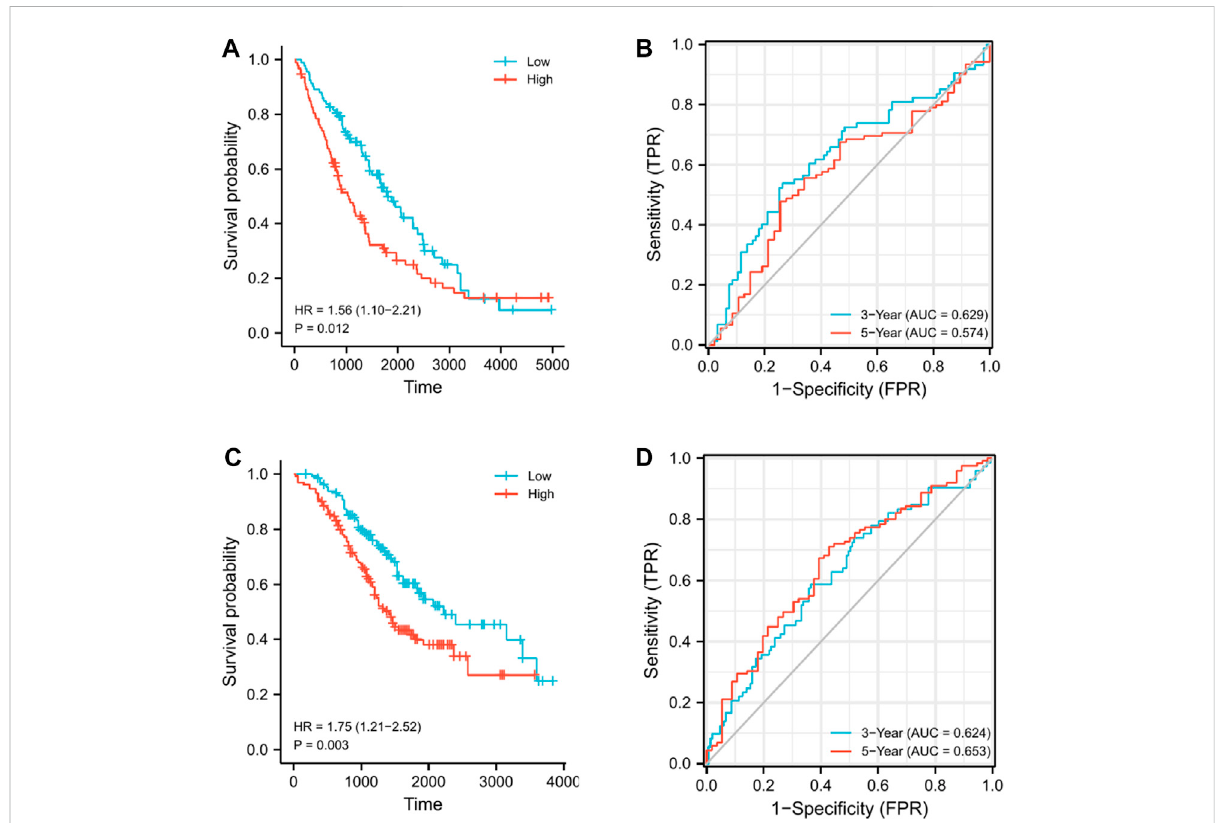
FIGURE 7 Validation of the nine-gene signature model in GEO cohorts. (A) Kaplan – Meier curves for the OS of patients in GSE26712, which was divided into high- and low-risk groups. (B) AUC of time-dependent ROC curves for predicting 3- and 5-year OS in GSE26712. (C) Kaplan – Meier curves for theOSofpatientsinGSE32062, whichwasdividedintohigh-andlow-risk groups. (D) AUCoftime-dependentROCcurves forpredictingthe3-and 5-year OS in